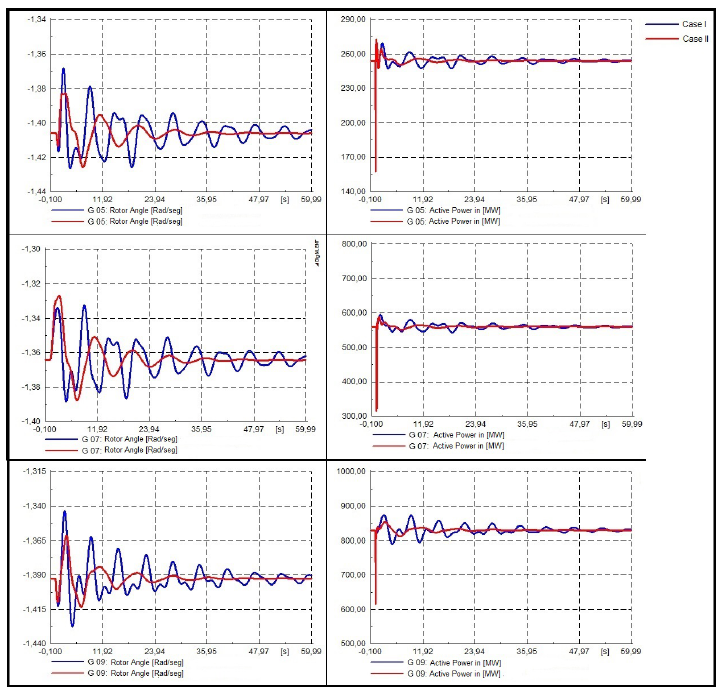
Figure 22. Rotor angle [rad] and Active Power [MW]-three phase fault at bus 15. 2. Three phase fault at bus